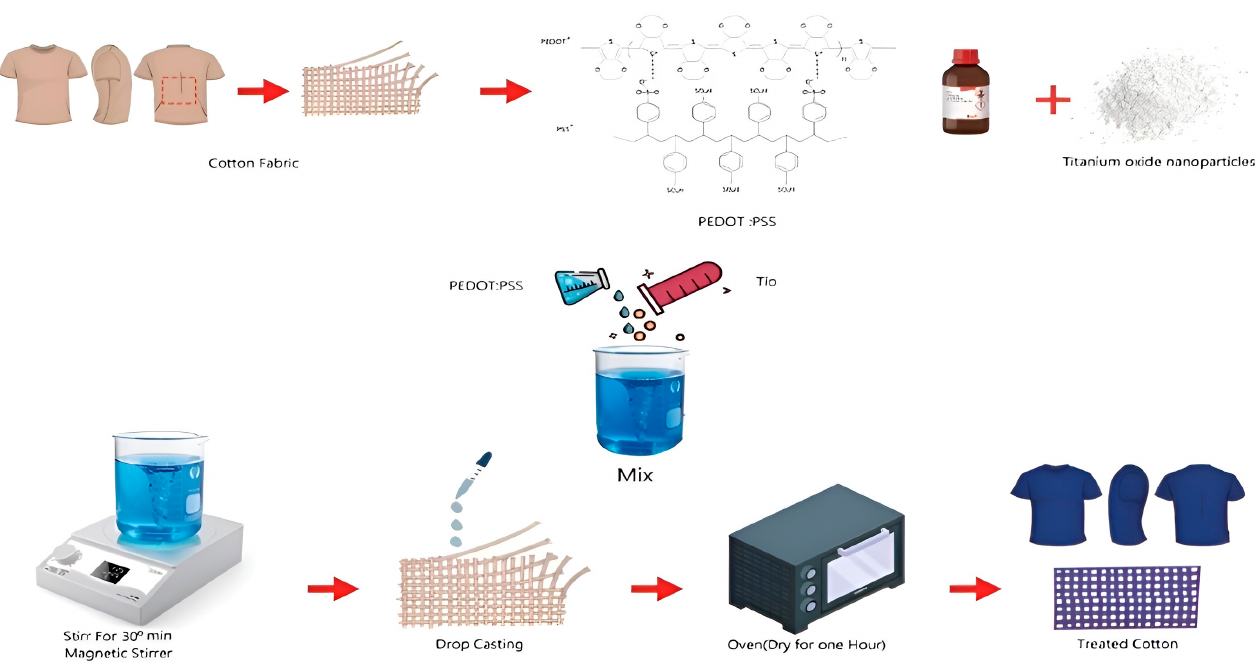
Figure 1. Diagrammatic representation of the fabrication of a conductive cotton fabric based on PEDOT:PSS/TiO 2 nanocomposite, including the preparation of the mixed solution and the chemical structure of PEDOT:PSS.